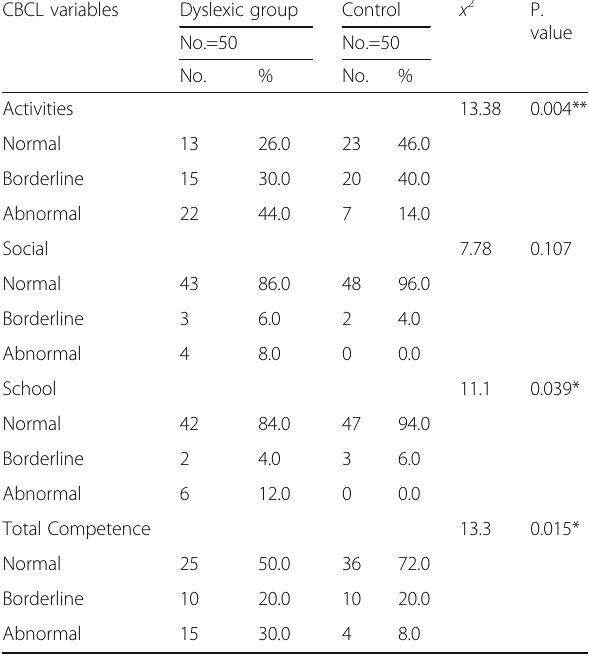
Table 4 Frequency distribution of different levels of competence scale of CBCL among dyslexic and control group Dyslexic group